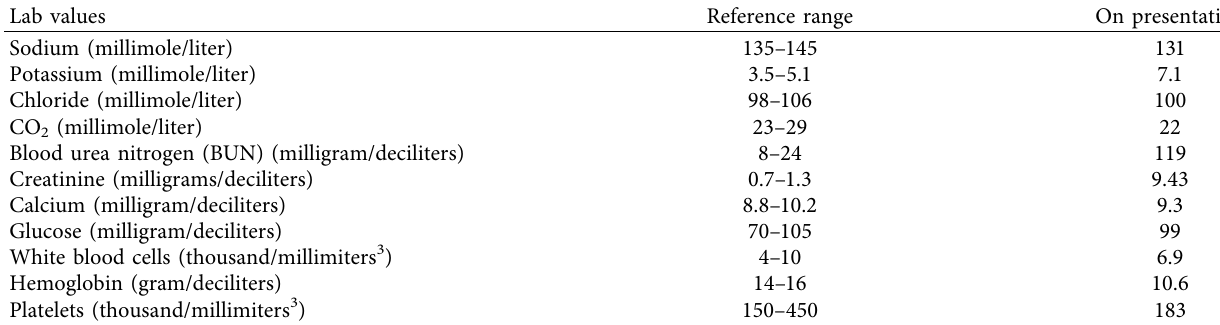
Table 1: Admission labs.